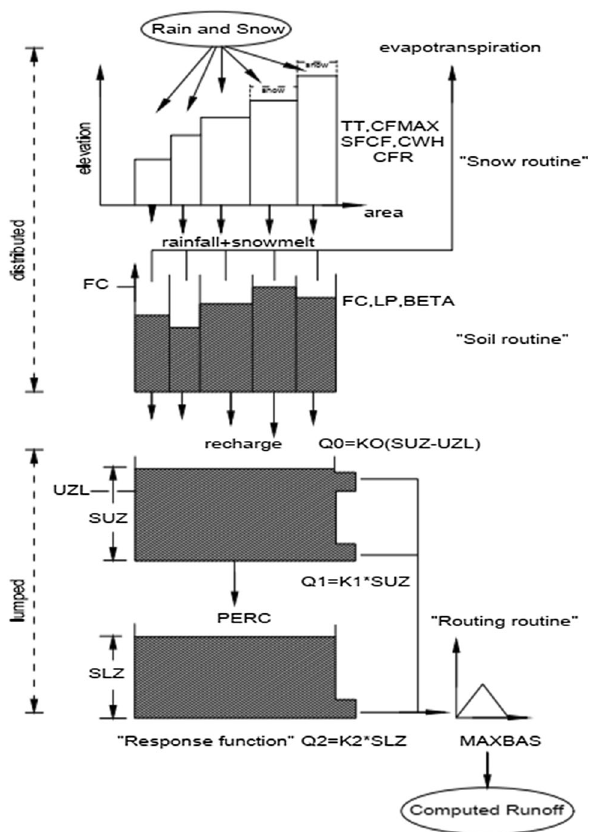
Fig. 2 Structure of HBV model (Seibert